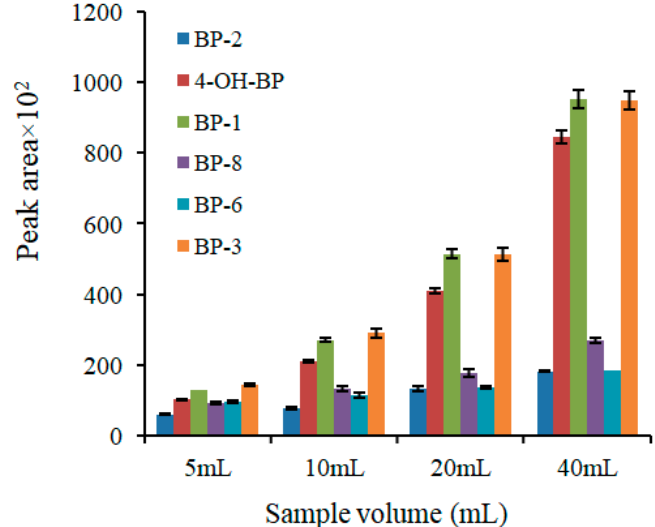
Figure 5. The effect of the sample volume on the efficiency of extraction. Extraction conditions: Elution solvent, mixture of 1-propanol and 0.01 M NaOH solution (50:50, v / v ); extraction time, 30 min; sample pH, 7.4. The analytes are: 2,2 ′ ,4,4 ′ -tetrahydroxybenzophenone (BP-2), 4-hydroxybenzophenone (4- OH-BP), 2,4-dihydroxybenzophenone (BP-1), 2,2 ′ -dihydroxy-4-methoxybenzophenone (BP-8), 2,2 ′ - dihydroxy-4,4 ′ -dimethoxybenzophenone (BP-6), and 2-hydroxy-4-methoxybenzophenone (BP-3).